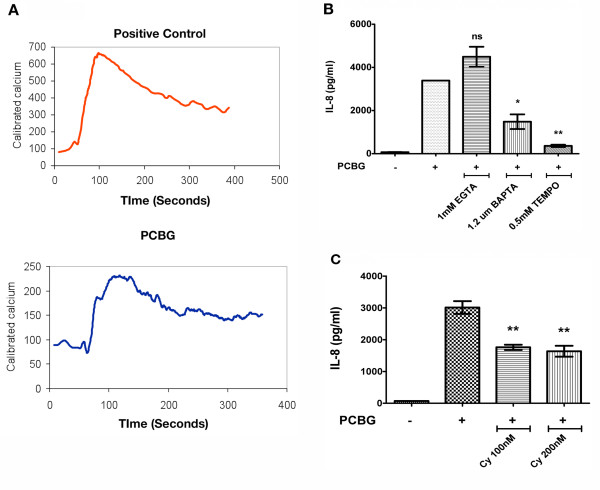
Intracellular calcium mobilization after PCBG stimulation. A. Airway epithelial cells (1HAEo-cells) were loaded with Fura-2AM and incubated with either 100 ug/ml of PCBG or with PAR-2 Peptide control (100 μM) for the indicated times and transient intracellular calcium release monitored by video fluorescence imaging. B. In additional experiments, airway epithelial cells were incubated with 100 ug/ml of PCBG. For one hour prior to the addition of PCBG, the cells were preincubated with various calcium and calcineurin disrupting agents (EGTA, BAPTA, or TEMPO) at the concentration indicated. IL-8 secretion was measured by ELISA in the supernatant of the cells after eight hours of incubation. C. Finally, airway epithelial cells were incubated with 100 ug/ml of PCBG for eight hours in the presence of cyclosporine A at the indicated concentration and IL-8 secretion measured by ELISA. Data were analyzed with one-way ANOVA and posttest Bonferroni comparison (*denotes p < 0.05; **denotes p < 0.01). The data shown are representative of three independent experiments.